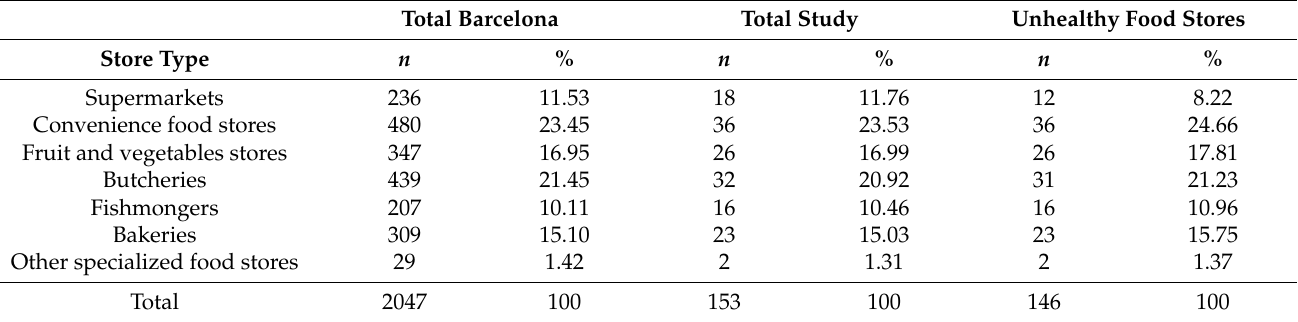
Table 1. Food retailers by store type found within 400 m of schools in Barcelona as a whole, overall and for the sample of establishments classified as unhealthy (Barcelona,